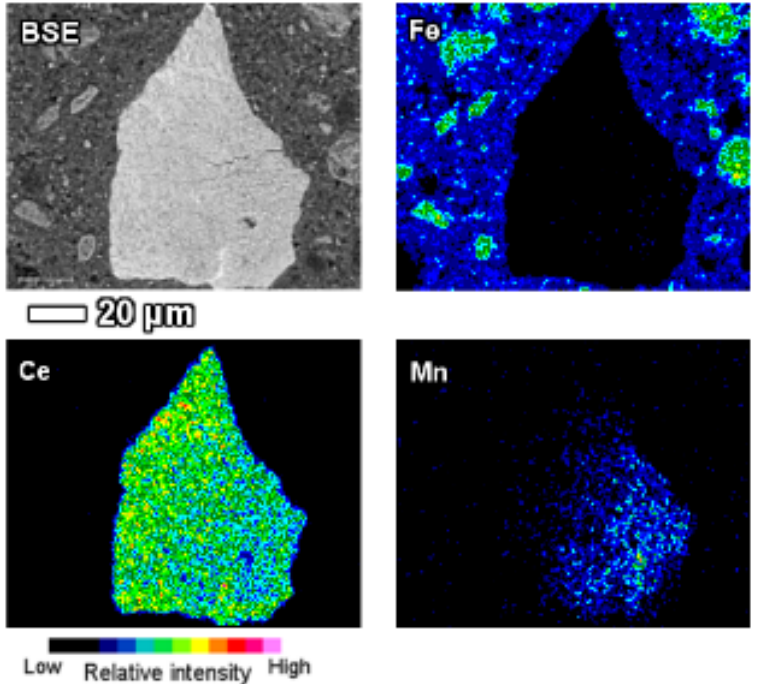
Figure 14. Cerium oxide/oxyhydroxide phase associated with manganese.